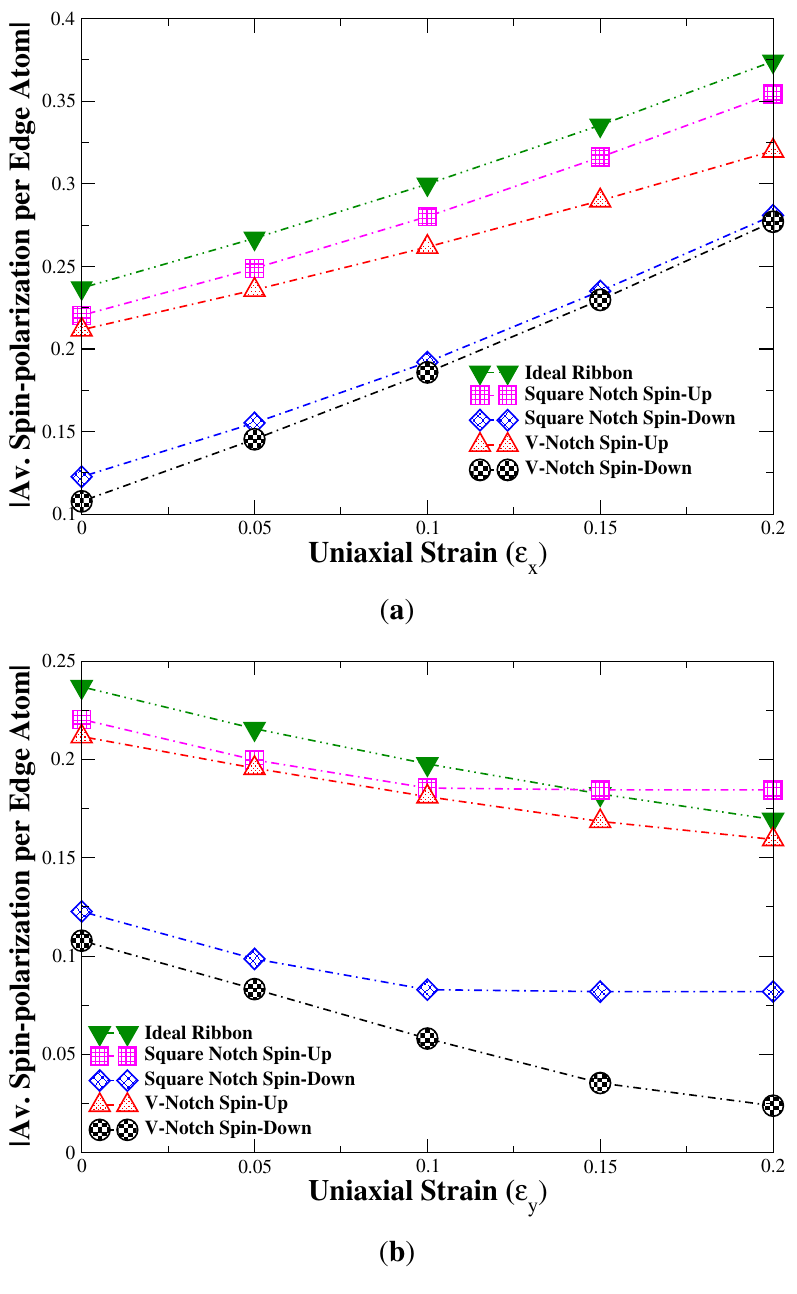
Figure 4. (Color on-line). The effects of uniaxial strain in the ( a ) x -direction, and ( b ) y -direction on the average spin-polarization (net spin-up & net spin-down) per edge-atom (including the notch region) for an ideal, square notch and V-shaped notch ZGNR system. The results for the ideal ribbon show similar trends to those reported in